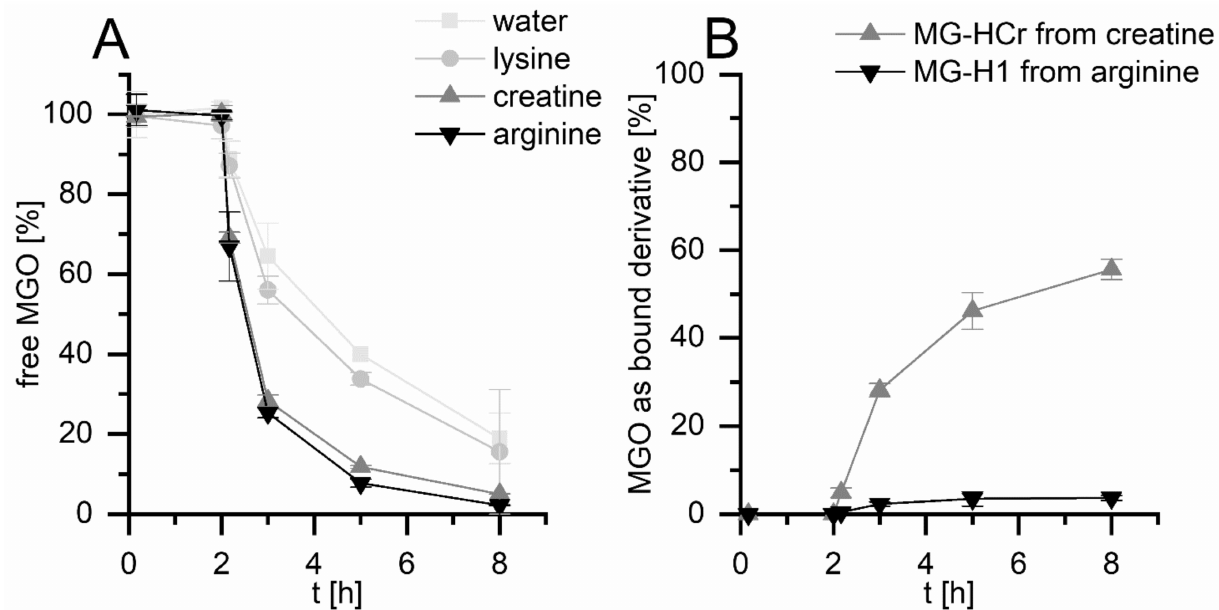
Figure 1. Simulated digestion experiments (2 h gastric stage, 6 h intestinal stage) of MGO with and without arginine, lysine, and creatine (molar ratio 1:10) in the presence of added digestive enzymes/bile. Decrease in unbound MGO measured with HPLC–UV ( A , B ); formation of bound MGO in the form of MG-HCr (from creatine) and MG-H1 (from arginine) measured with HPLC–ESI– MS/MS ( B